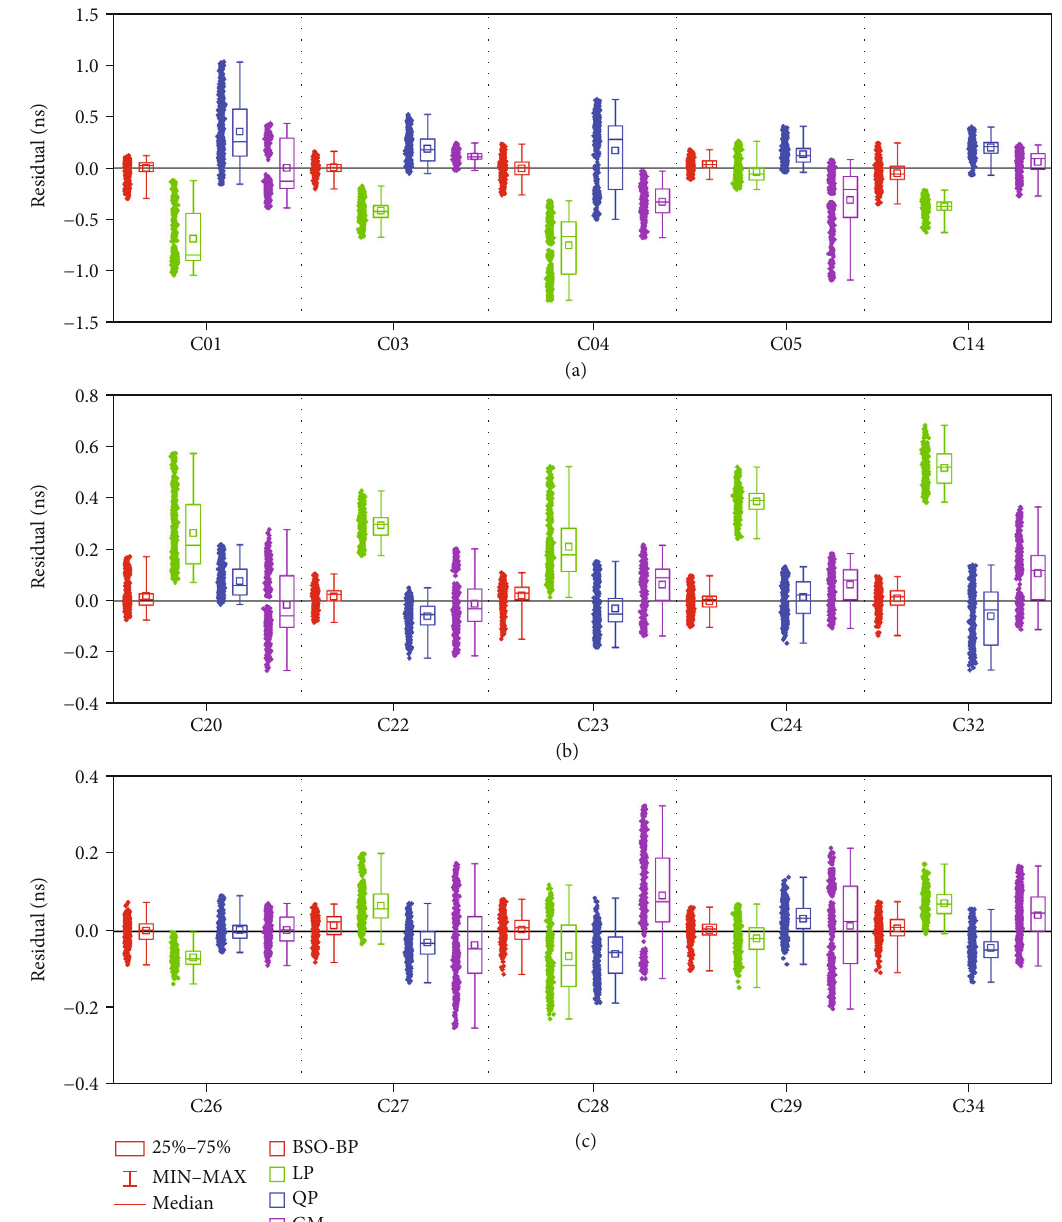
Figure 12: The statistics of 1-hour average STD of four models based on 6-hour SCB data: (a) residual distribution of fi ve Rb clocks; (b) residual distribution of fi ve Rb-II clocks; (c) residual distribution of fi ve PHM